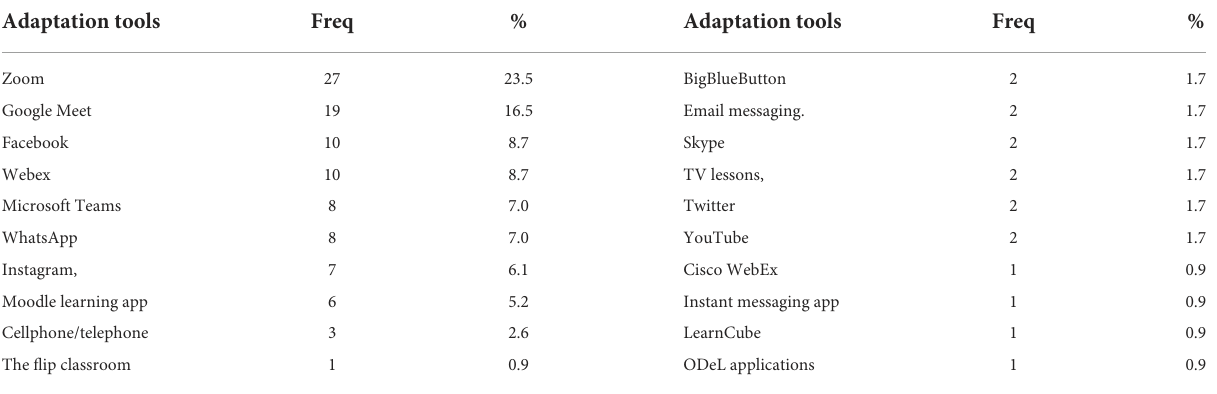
TABLE 10 Adaptation